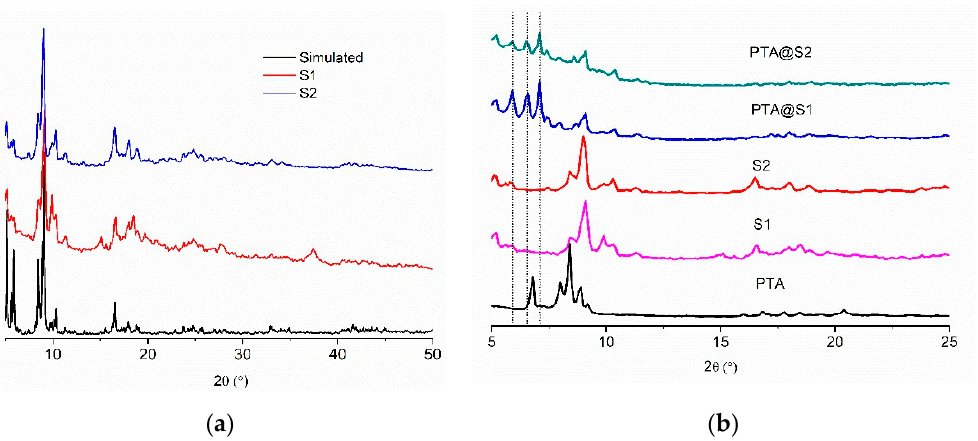
Figure 1. ( a ) The powder x-ray diffraction (PXRD) patterns of S1 and S2 compared with simulated pattern of MIL-101, which was generated from the deposited x-ray data file at the Cambridge Structure Database (CSD-Refcode OCUNAK) [6]. ( b ) The PXRD patterns of S1, S2, PTA@S1, PTA@S2 and pure PTA.